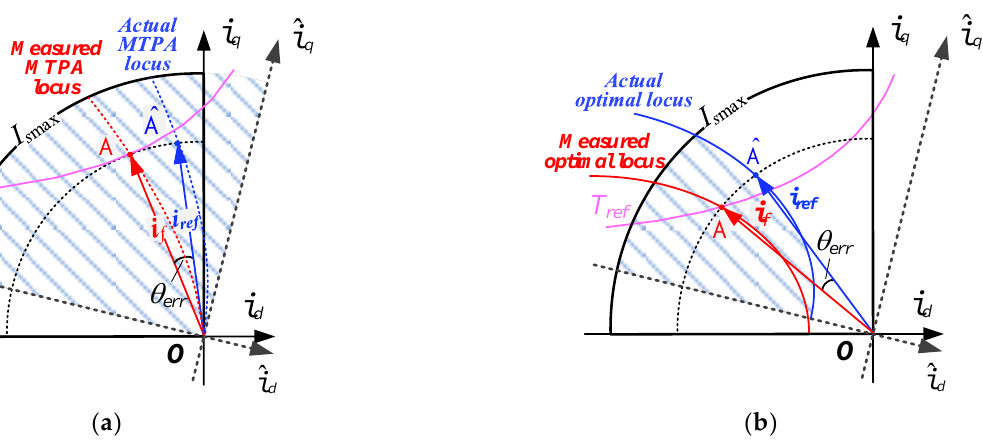
Figure 7. Current sampling delay in PMSM control system.